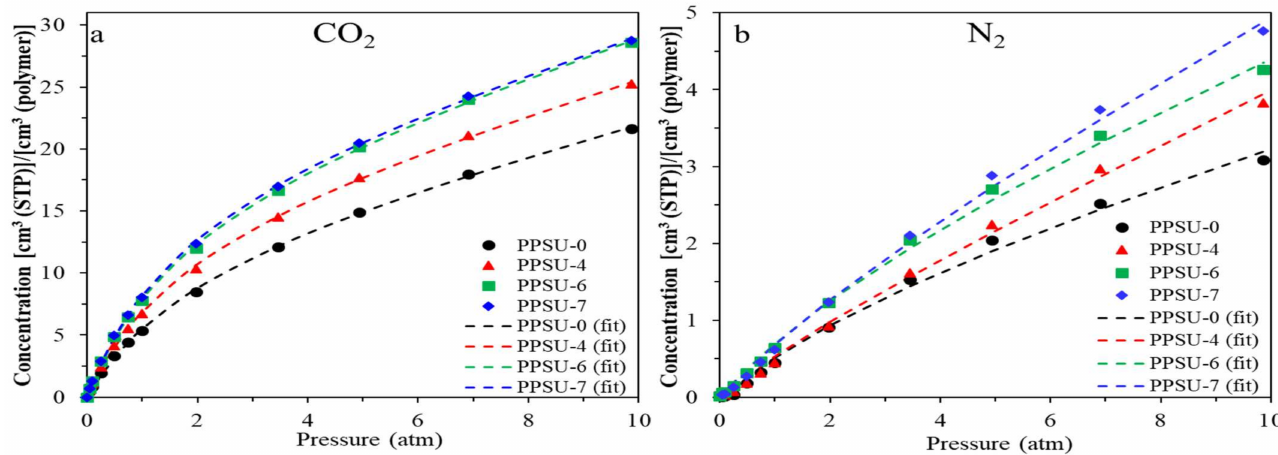
Figure 10. Sorption isotherms at 35 ◦ C for PPSU-0, -4, -6, and -7: ( a ) CO 2 , ( b ) N 2 . Table 5. Diffusion coefficients and solubility coefficients of PPSU/TMPPSf polymers samples.